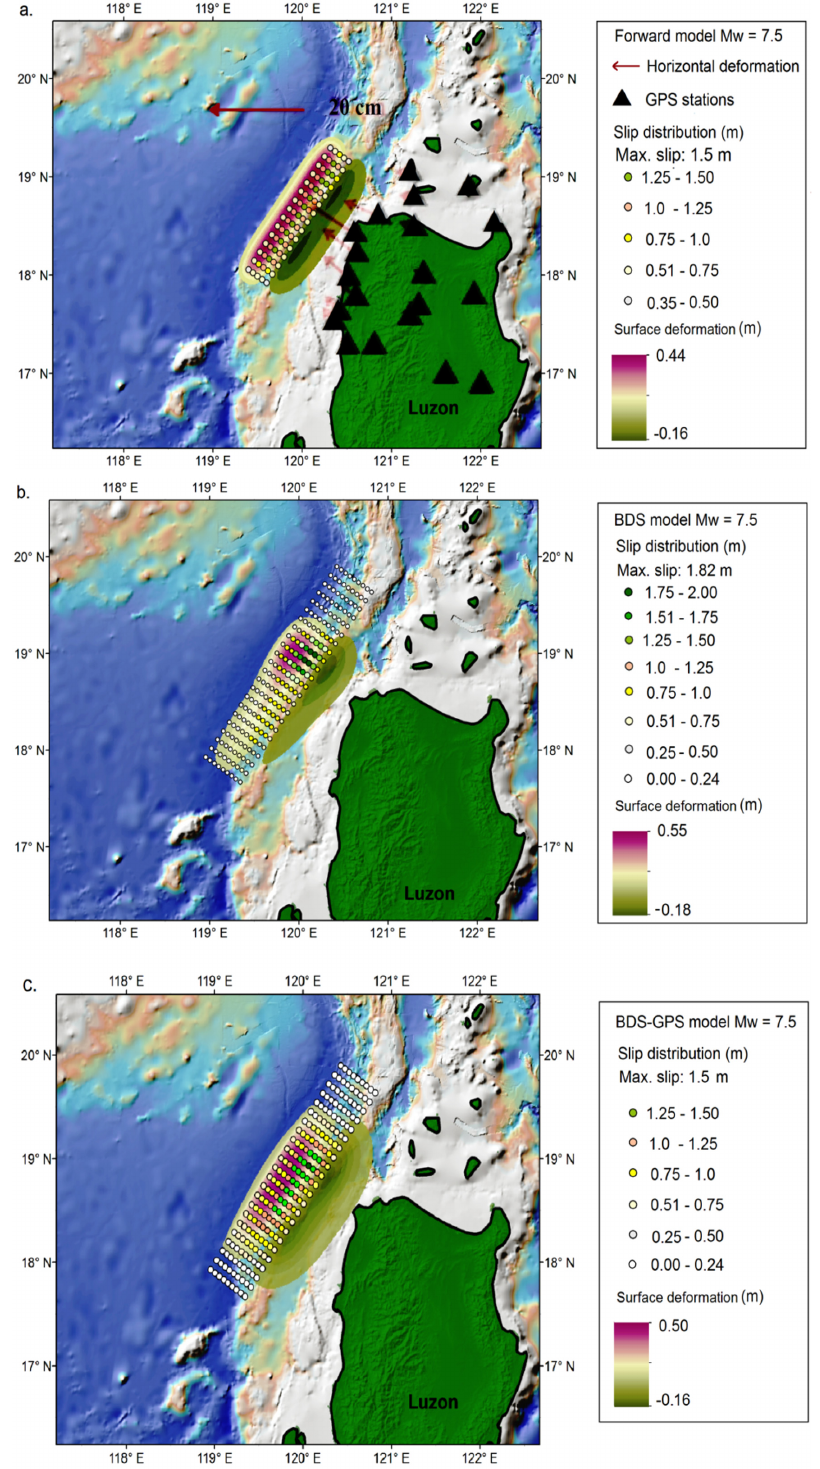
Figure 6. ( a ) Assumed slip distribution (colored dots) and correspondent co-seismic surface deformation for an event with a magnitude of Mw = 7.5 rupturing along the Northern Manila mega-thrust. Red arrows show horizontal displacements computed at the virtual BDS/GPS network (black triangles); ( b ) Colored dots show slip distribution as inverted from the simulated BDS-displacements (note, synthetic BDS-displacements include real-time processing noise). Additionally shown is the resulting vertical deformation; ( c ) Same as (b), but for the inversion of the joint BDS/GPS displacements.